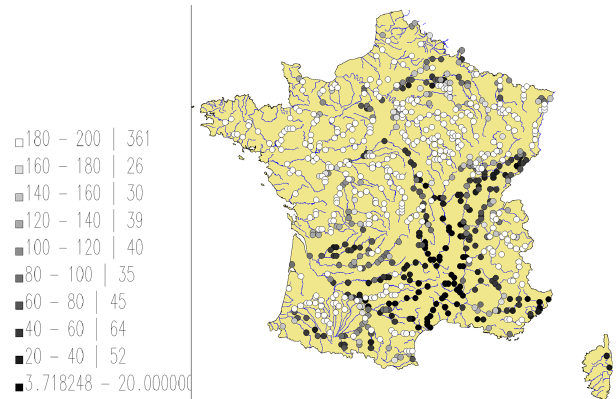
Fig. 4. Return period under climate change associated with the present time 100-yr return period level. The downscaling technique is WT and the future time period is 2035–2064. Increases in return period above doubling (e.g. the probability is divided by more than 2) are figured as doubling.